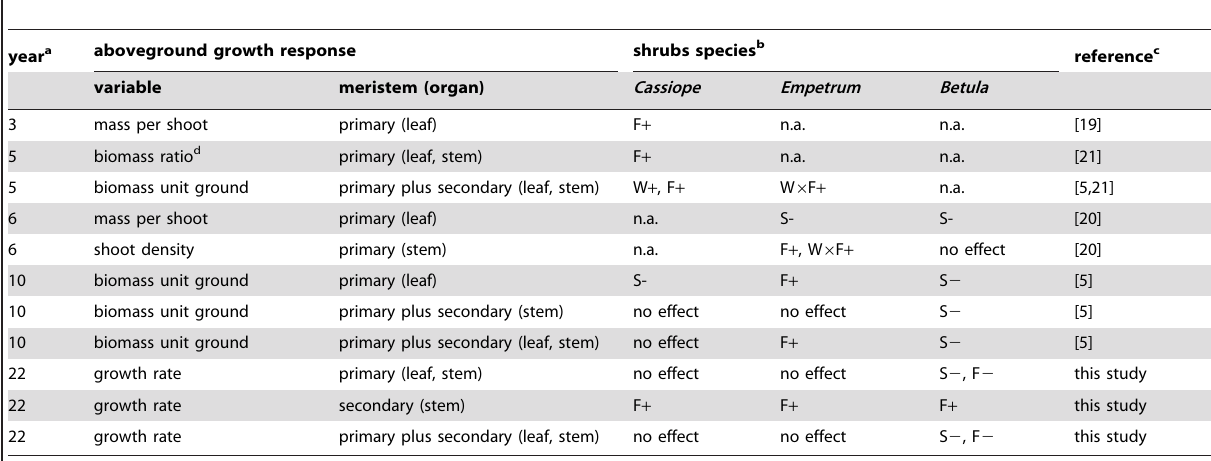
Table 3. Synthesis of the significant impact of shading (S), warming (W), fertilisation (F) and their interactions on the growth of the tundra shrubs Cassiope tetragona , Empetrum hermaphroditum and Betula nana